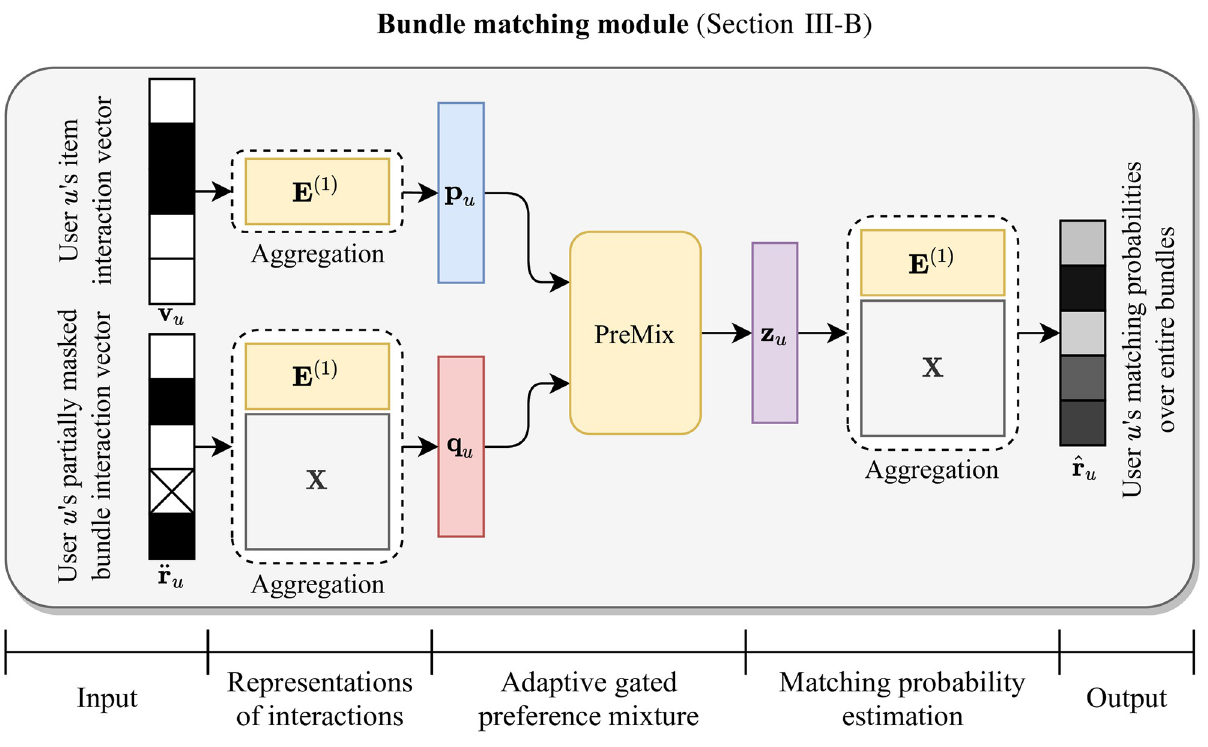
Fig 2. The architecture of bundle matching module in BundleMage.